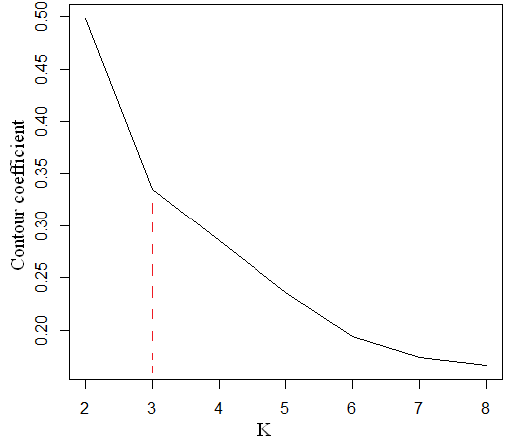
Figure 2. Relationship between the contour coefficient and K.